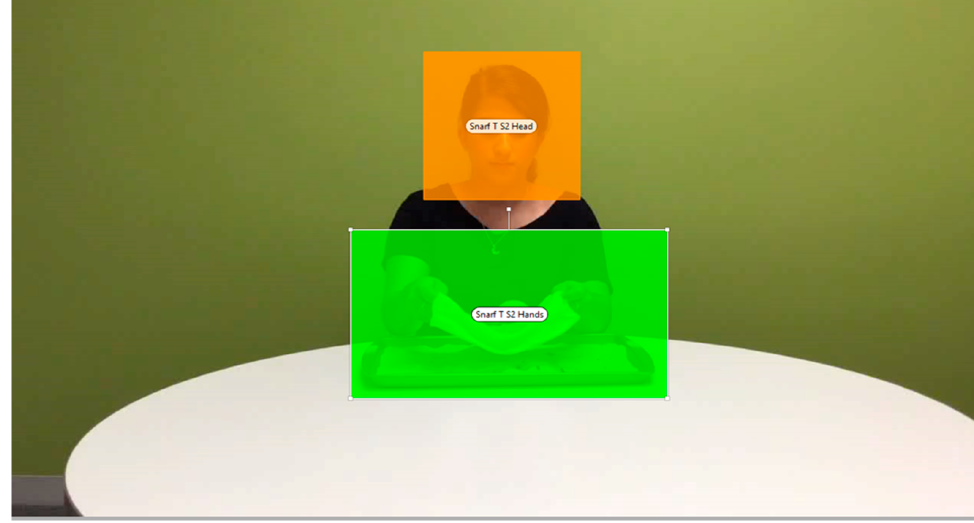
Figure 2. Example of AOIs drawn for the head region and the hands region.